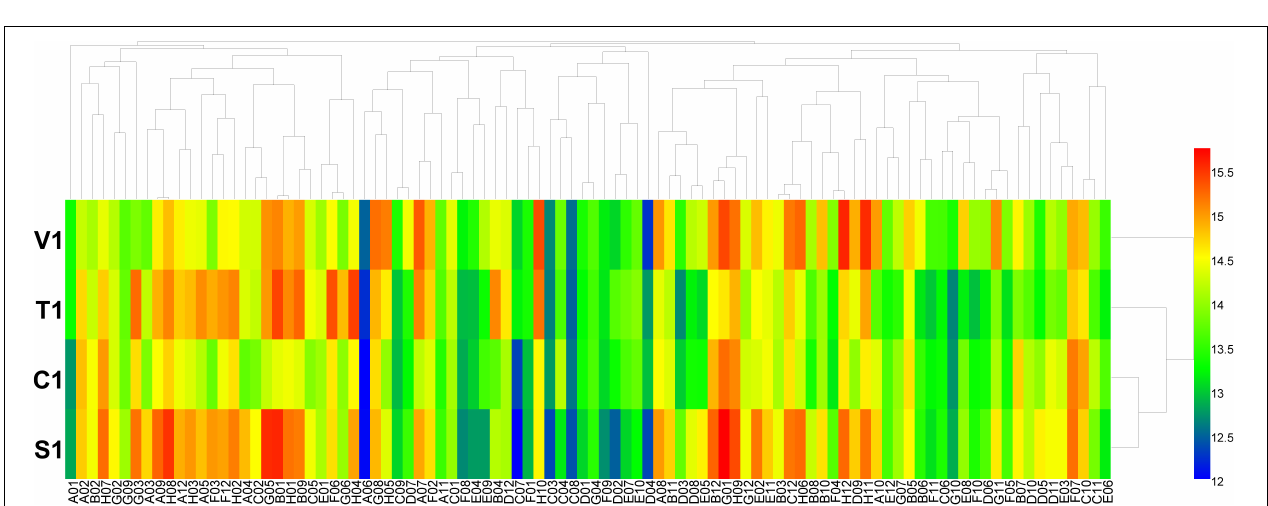
FIGURE 2 | Overview of metabolic phenotypes of four isolates of B. cinerea on 95 nitrogen (N) sources tested. V1, T1, C1, and S1 were the isolates of B. cinerea from tomato, tobacco, cucumber, and strawberry, respectively. Heatmap of maximum area values of 95 N sources expressed as maximum curve area monitored during 96 h of incubation. The legend of color code from blue to green, and red shades indicate low, moderate, and high utilization of N sources, respectively, assessed as arbitrary Omnilog values.